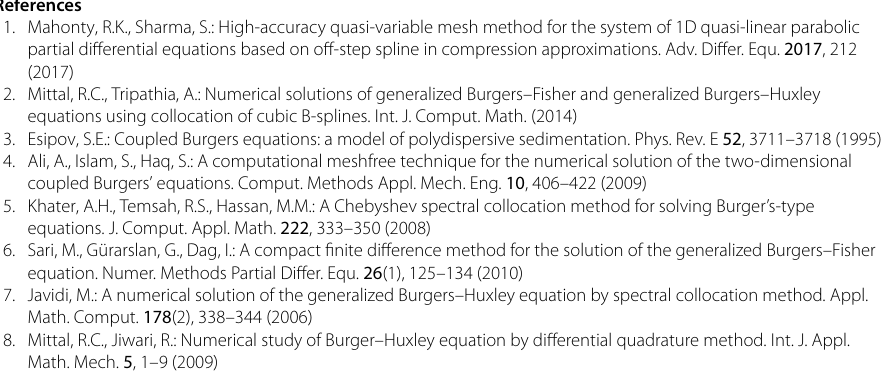
exact and available results in the literature. From comparison it is clear that the proposed technique gives a better accuracy and is easy to